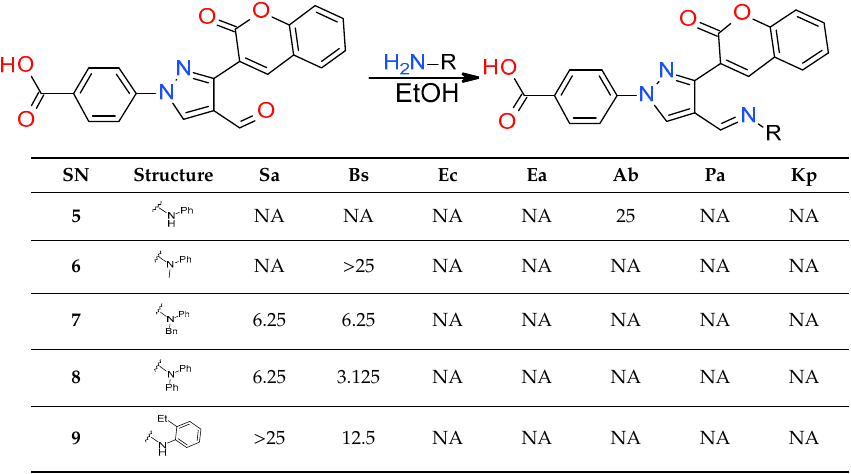
Table 1. Synthesis and antimicrobial activity of coumarin-substituted hydrazone derivatives, Gram-positive bacteria: S. aureus ATCC 25923 (Sa) and B. subtilis ATCC 6623 (Bs), Gram-negative bacteria: Escherichia coli ATCC 25922 (Ec), E. aerogenes ATCC 13048 (Ea), A. baumannii ATCC 19606 (type strain), Pseudomonas aeruginosa 27833 (Pa), Klebsiella pneumoniae ATCC 700603 (Kp), and NA = no activity (compounds did not show any noticeable activity up to 50 μ g/mL concentration). Values are the average of two closely related experimental values.